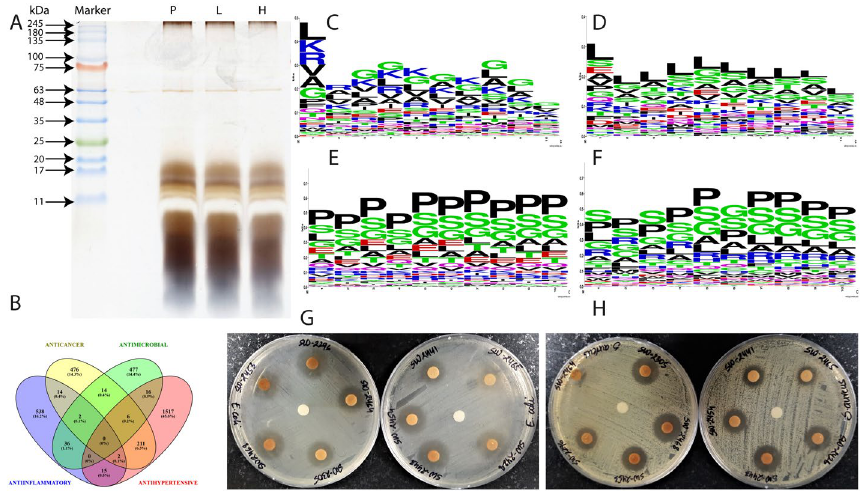
Figure 3. ( A ) After subjecting <10 kDa cow urine fraction to Solid Phase extraction, the eluate was collected in 60% ACN, 0.1% TFA. Ethyl acetate extraction of the eluate was carried out and the aqueous phase was separated and dried in Speed Vac. Aqueous extract pooled from different physiological states viz. Heifer, Lactation, and Pregnant (left to right) of Sahiwal cattle were then visualized by tricine-SDS PAGE. ( B ) Venn diagram showing the number of common peptide sequences shared by different classes of predicted bioactivity. ( C ) N terminal (10 amino acids) sequence logos were generated for the sequences predicted with certain bioactivity. Antimicrobial Peptide sequences showed glycine, lysine, and leucine as dominant residues. ( D ) Sequence logo for predicted Anti-Inflammatory sequences, every position is predominated by leucine residue. ( E ) Sequence logo for predicted Antihypertensive sequences with Proline as dominant residue. ( F ) Sequence logo for predicted Anticancer sequences with Proline as dominant residue. Both antihypertensive and anticancer sequences show proline as the dominant amino acid at almost every position. ( G ) 20 µL of Solid Phase Extract eluate from 10 individual animals (Heifer) was coated on 6mm sterile disc and placed on Staphylococcus aureus lawn (equivalent to 0.5 McFarland units). Zone of Inhibition was observed after 12–18 h of incubation. Disc in the center is a negative control containing 20 µL of BSA digest. ( H ) Peptide extracts activity against Escherichia coli (equivalent to 0.5 Mc Farland). Disc in the center is a negative control containing 20 µL of BSA